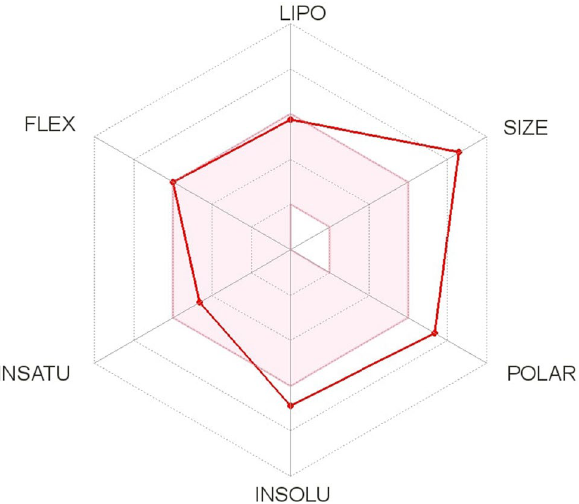
Figure 2. Bioavailability radar of Aspergillipeptide D.